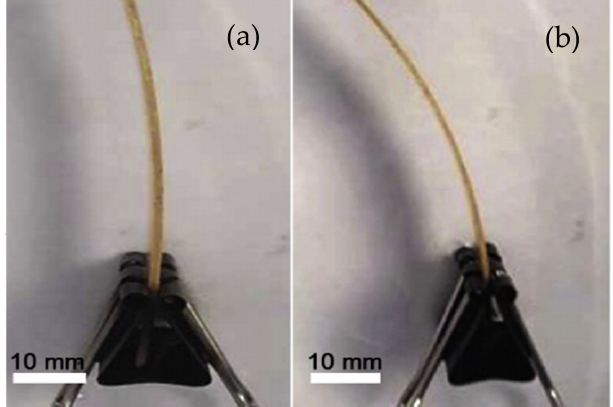
Figure 5. Hygromorph biocomposite produced by fused filament fabrication (FFF): ( a ) before and ( b ) after immersion in water [70].